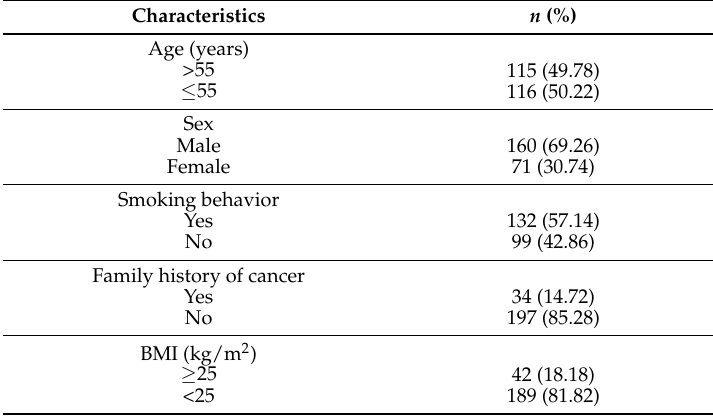
Table 1. General characteristics of the patient population ( n =